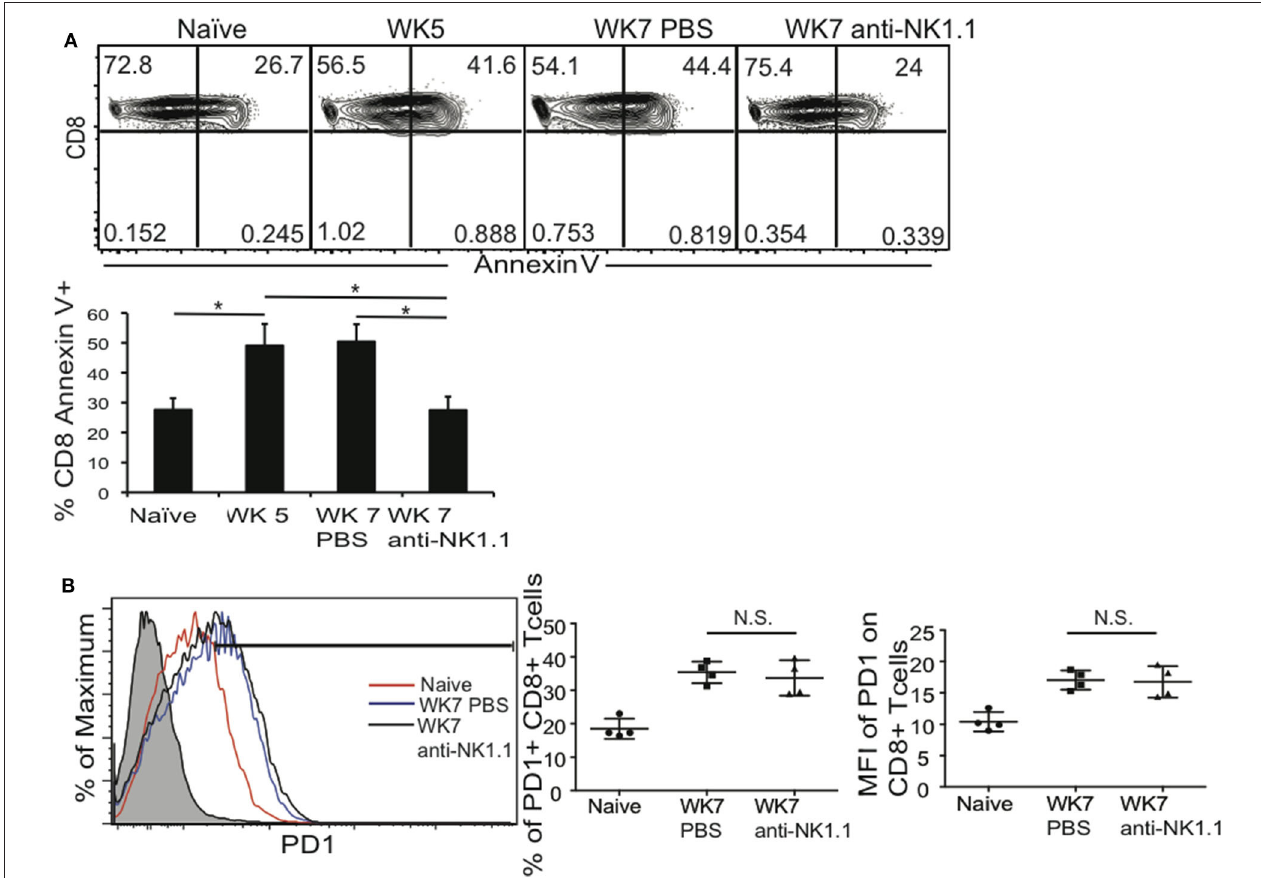
FIGURE 4 | NK cells increase CD8 + T cells apoptosis during chronic T. gondii infection. C57BL/6 mice were infected and some groups at week 5 after infection were treated with anti-NK1.1 or 1 X PBS i.p. as described. Week 5, week 7 non-treated and week 7 treated infected mice were sacrificed and spleen cells isolated for CD8 + T cell Annexin V staining and PD1 and compared to naïve animals. (A) Contour plots present frequency of Annexin V + CD8 + T cells and graphs present mean ± SD. (B) Histogram presents PD1 expression on splenic CD8 + T cells from anti-NK1.1 treated or not treated mice. Graphs present frequency and MFI of PD1 on CD8 + T cells. Data presented are from 1 experiment repeated 2 independent times with n = 4 mice per group. Significance is denoted by *with a p ≤ 0.05 non-significant results are denoted with